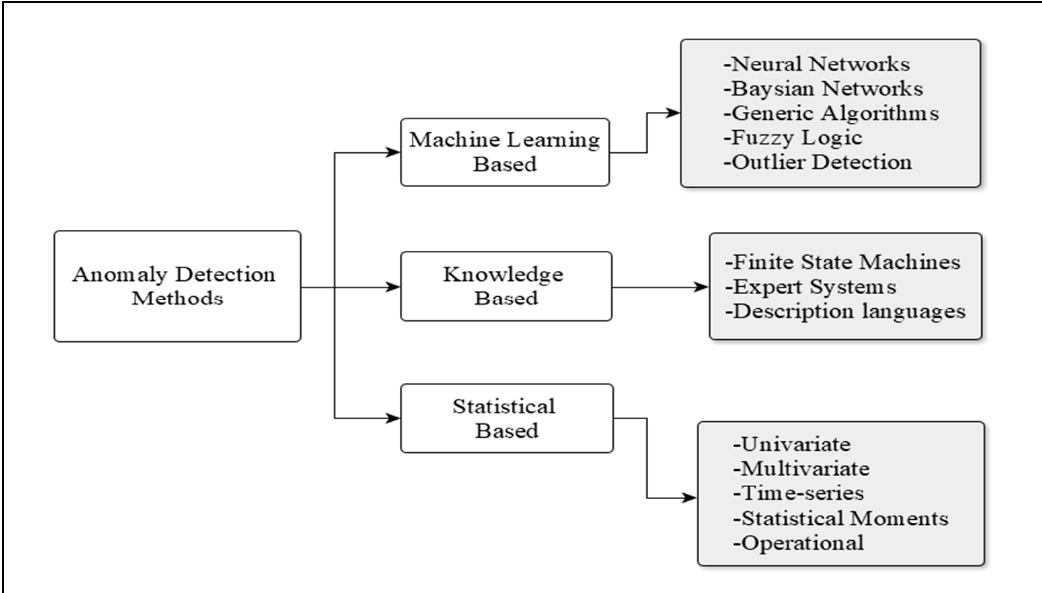
Figure 1. Classification of Anomaly-based IDS.